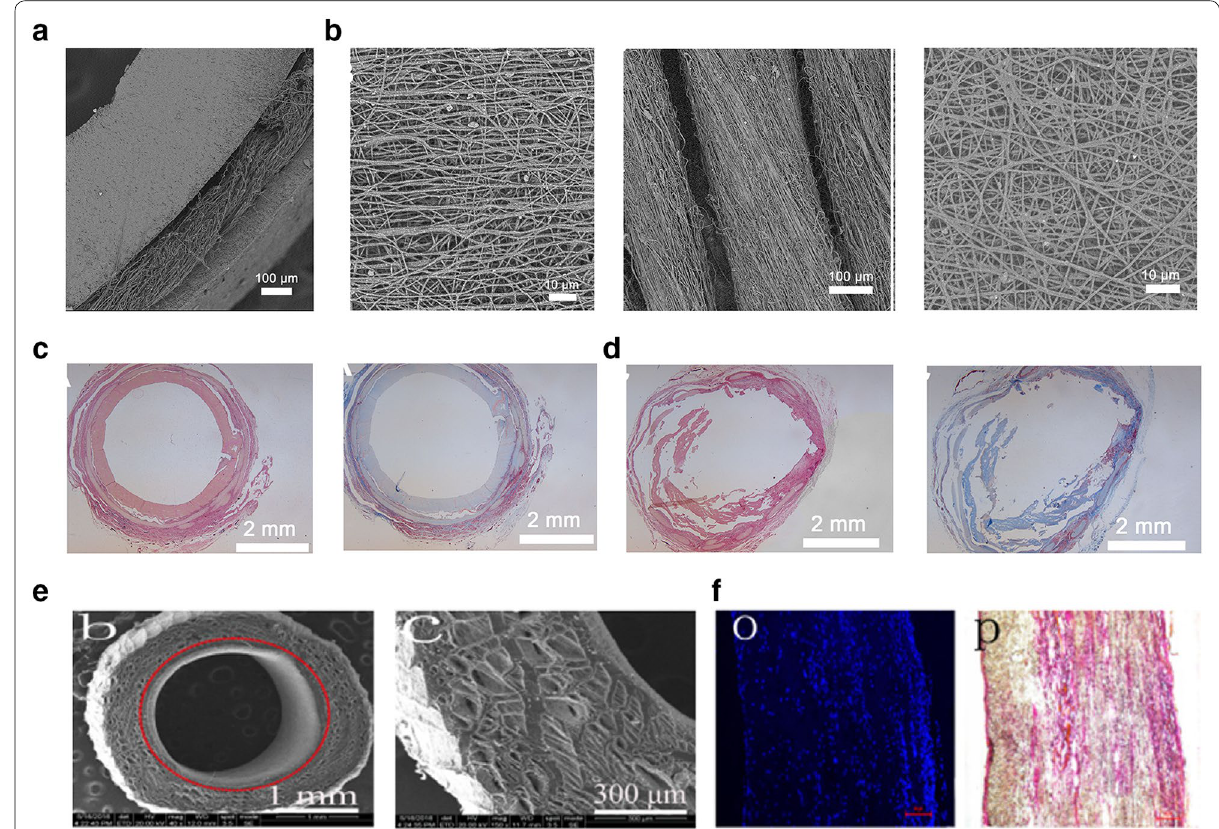
Fig. 5 a SEM images displaying a cross‑section of a tri‑layered tubular graft. b The aligned structure of PLCL/COL nanofibers in the inner layer (left), the PLGA/SF in the middle layer (middle), and randomly oriented PLCL/COL nanofibers in the external layer (right). c , d H&E (left) and Masson’s trichrome (right) staining images of transplanted grafts after 2 weeks and 10 weeks, respectively. Reprinted with permission from [126], Elsevier. e Cross‑sectional SEM image of vascular grafts and relevant high magnification (right). f DAPI (right) and H&E staining (left) of bilayer scaffolds implanted in Sprague–Dawley rats after 16 weeks. Reproduced with the permission from [127],